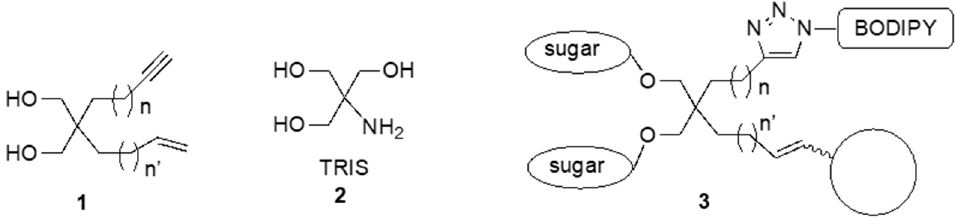
Figure 1. Tetravalent scaffold ( 1 ), Lee’s TRIS aliphatic scaffold ( 2 ), and target molecules ( 3 ) (this work). BODIPY: boron-dipyrromethene